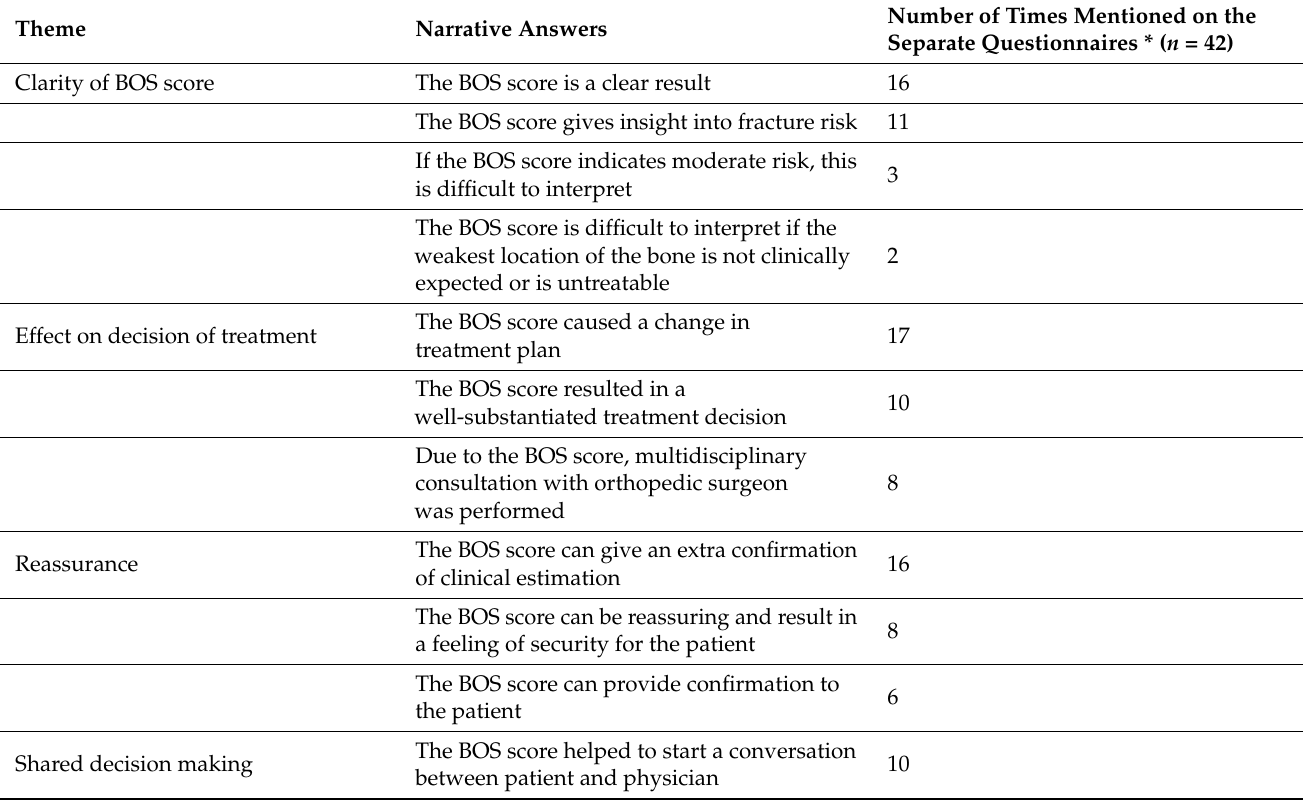
Table 3. Themes and findings from questionnaires that were filled in by